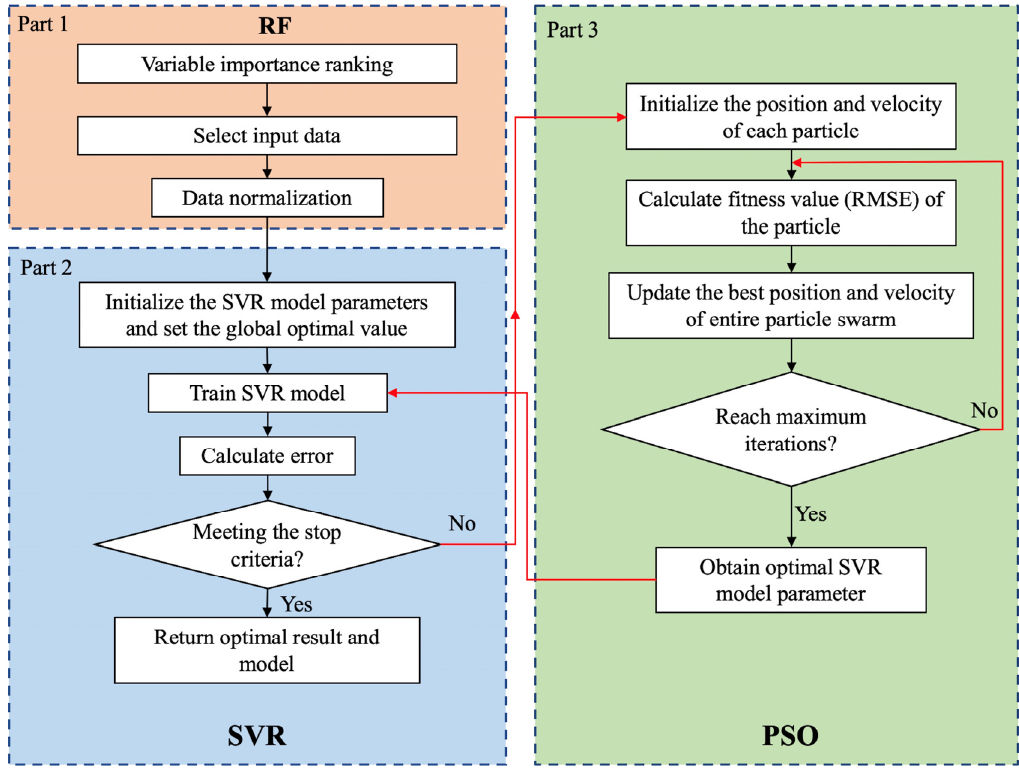
Figure 1. The flowchart of hybrid RF–SVR–PSO